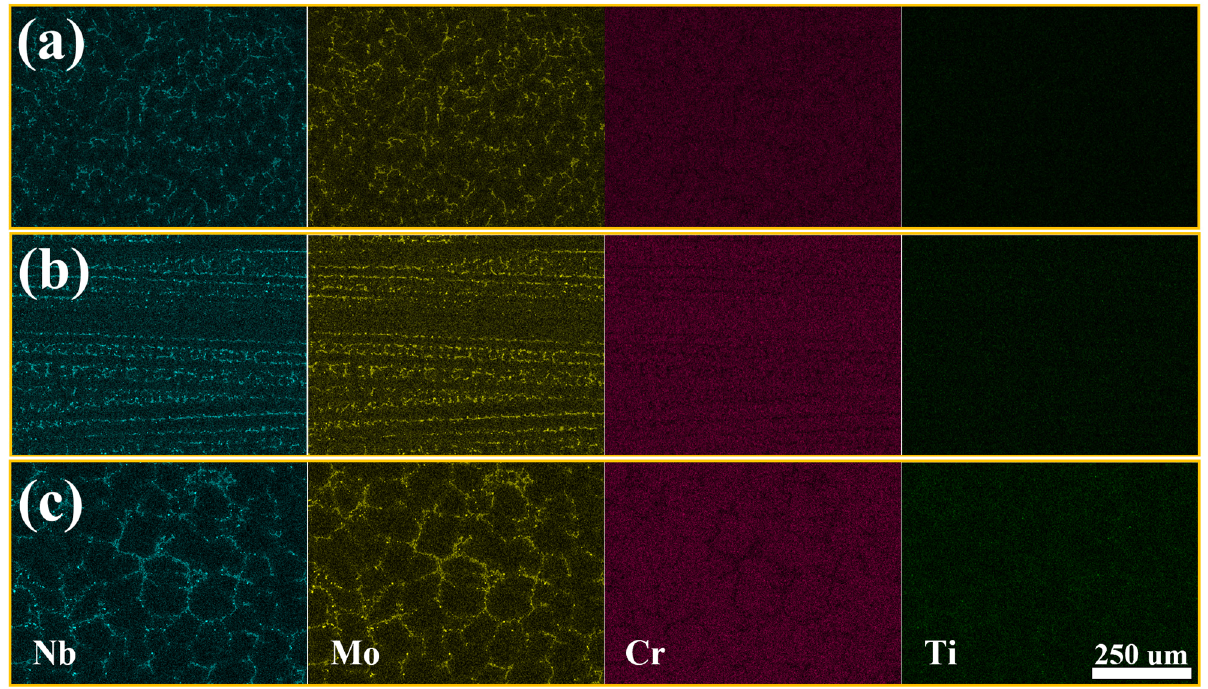
Figure 3. SEM-mapping micrographs showing the distributions of segregated elements in different positions of an ingot with etchant 2, ( a ) surface, ( b ) periphery, ( c ) R/2.